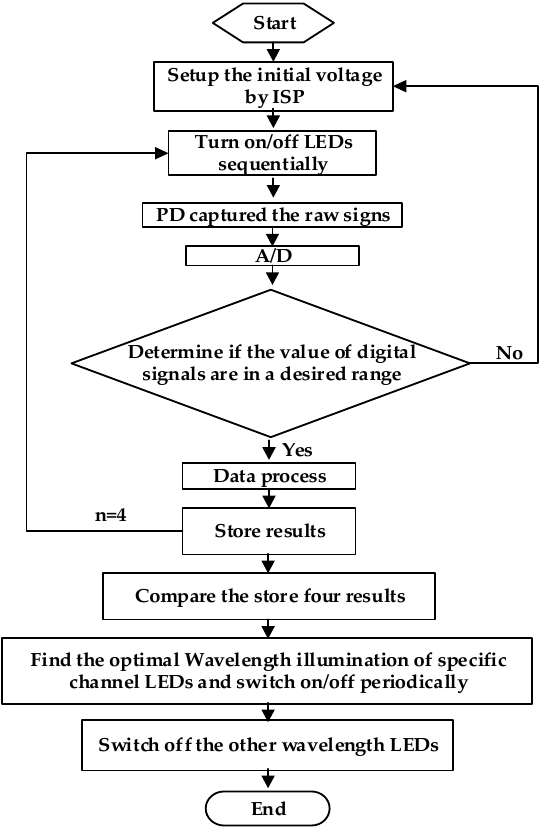
Figure 6. The flowchart against the effect of skin pigments.